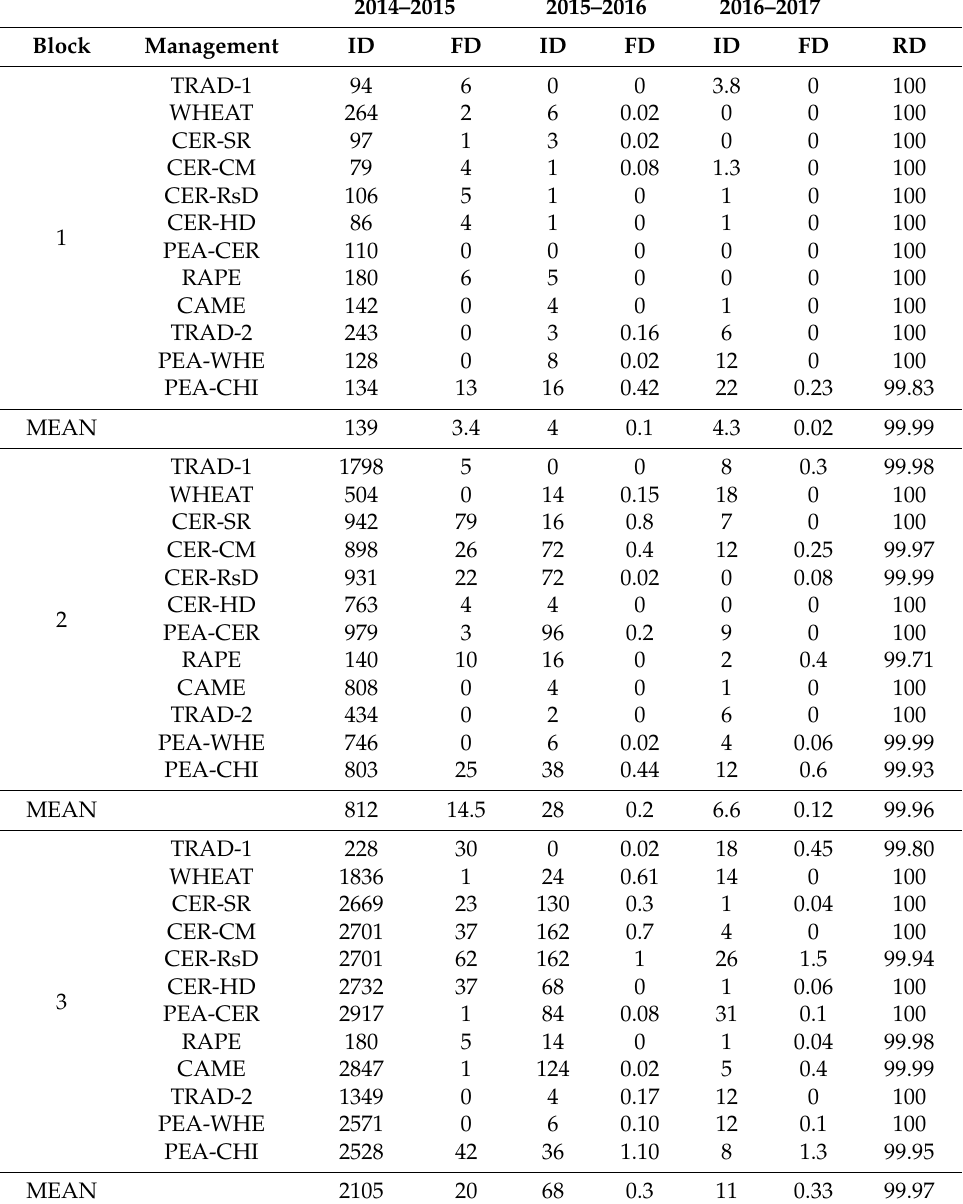
Table 7. Initial (ID) and final (FD) B. diandrus density means (plants m − 2 ) under different